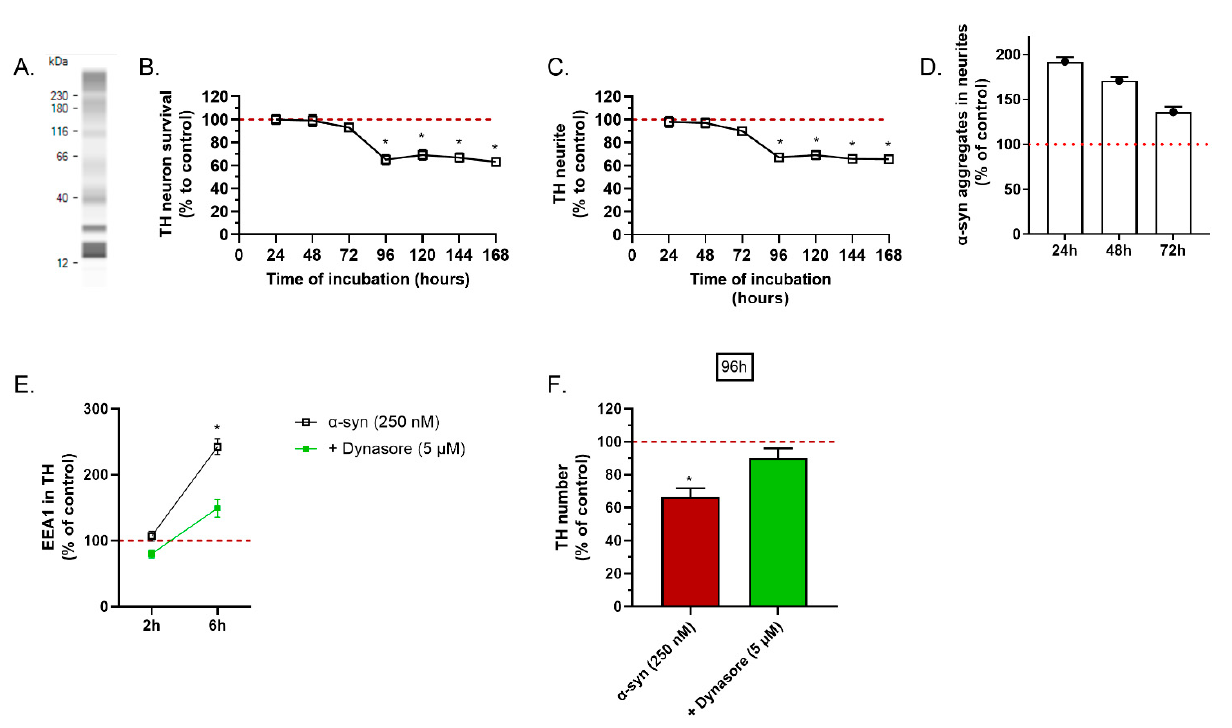
Figure 1. Effects of the different timing of α -syn incubation and dynasore on TH-expressing neurons and endocytosis. ( A ) WES analysis of α -syn preparation: virtual blot of the preparation composition. ( B ) Total number of TH(+) neurons (control = 23 ± 5), ( C ) length of TH(+) neurite network (control = 1261 µ m ± 7), ( D ) area of cytoplasmic α -syn in TH neurons (control = 24 µ m 2 ± 5) in TH neurons after treatment with α -syn were studied after different incubation durations. ( E ) Expression of EEA1 marker in TH neurons (control = 204 µ m 2 ± 6) were studied 2 h and 6 h after application of dynasore and ( F ) survival of TH(+) neurons 96 h after (control = 114 ± 6). All values were expressed